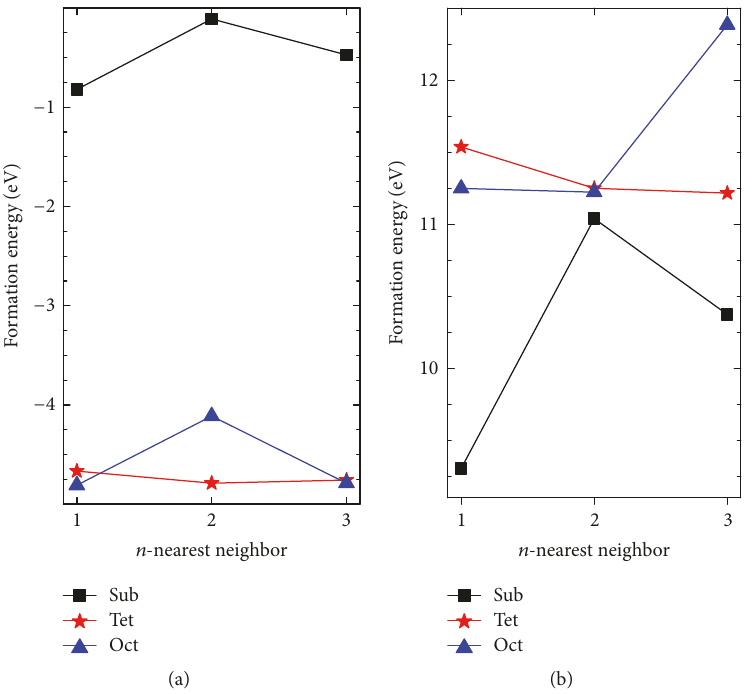
Figure 5: The formation energy of two H (a) and He (b) atoms located in the different sites.